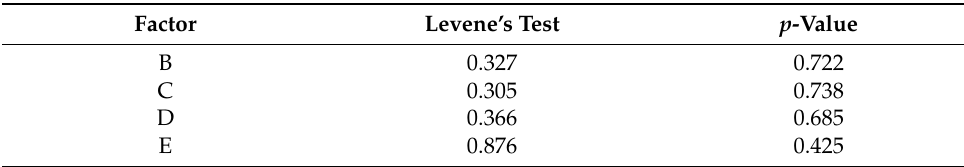
Table 8. Homoscedasticity test for MAPE.